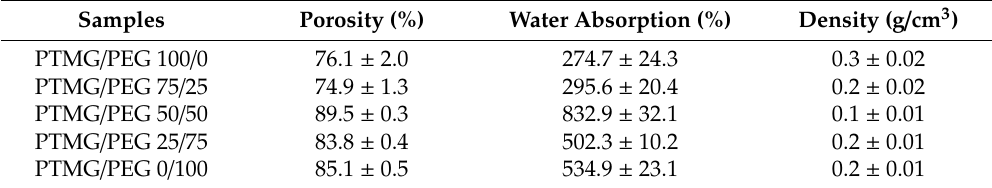
Table 3. Porosity, water absorption, and density of PTMG / PEG porous sca ff